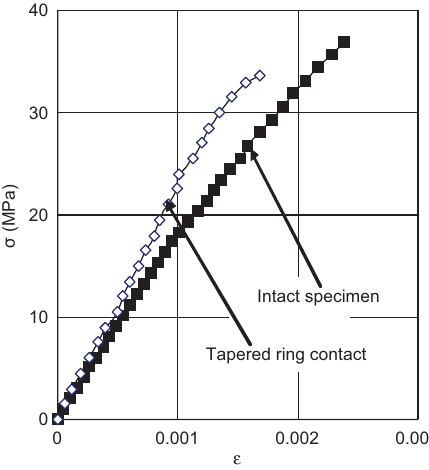
Figure 6 The infl uence of rimming on the stress-strain curve under uniaxial compression for the Alfopetra